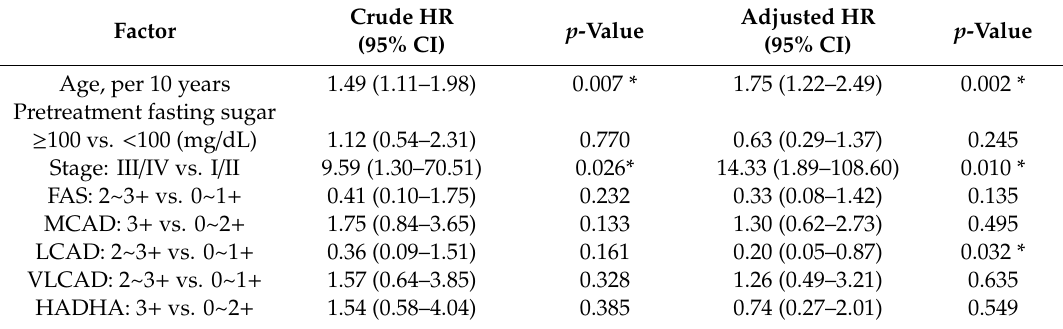
Table 5. Crude and adjusted HRs with 95% CIs for mortality related to clinical parameters and fatty acid oxidation-related expression of enzymes. Total case ( n = 102).